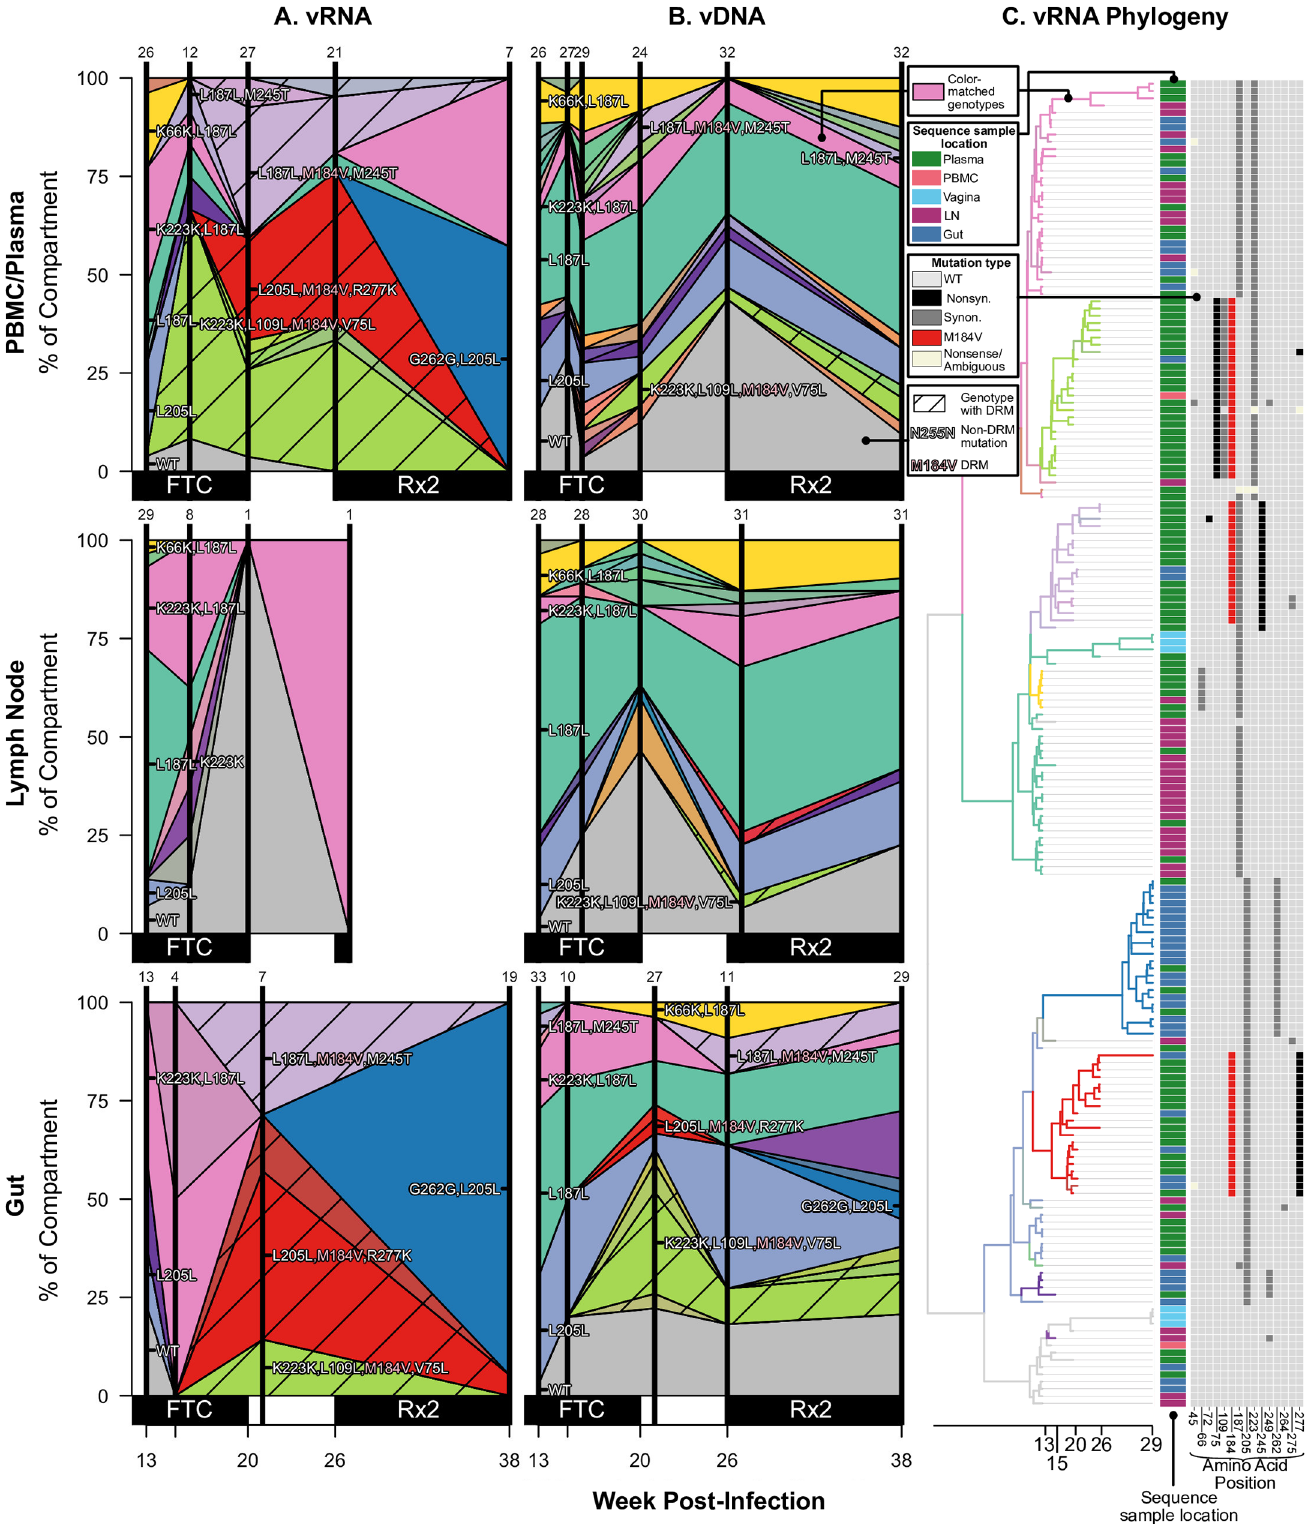
Fig 5. Drug resistance spreads dynamically across severalcompartments in macaque A99039over the course of treatment. Coloredpolygons show the prevalenceof different genotypes of RT-SHIV RNA (A) or DNA (B) over time in different compartments. Vertical distanceat black vertical lines